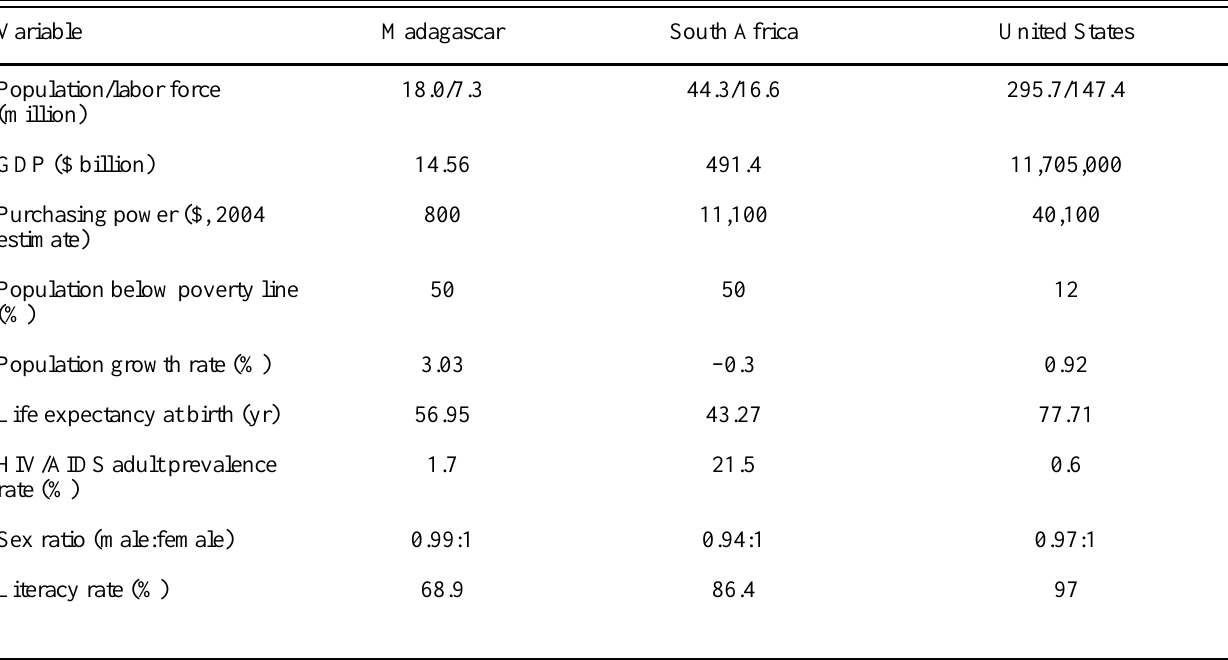
Table 1. Socioeconomic comparison of the three regions (Central Intelligence Agency